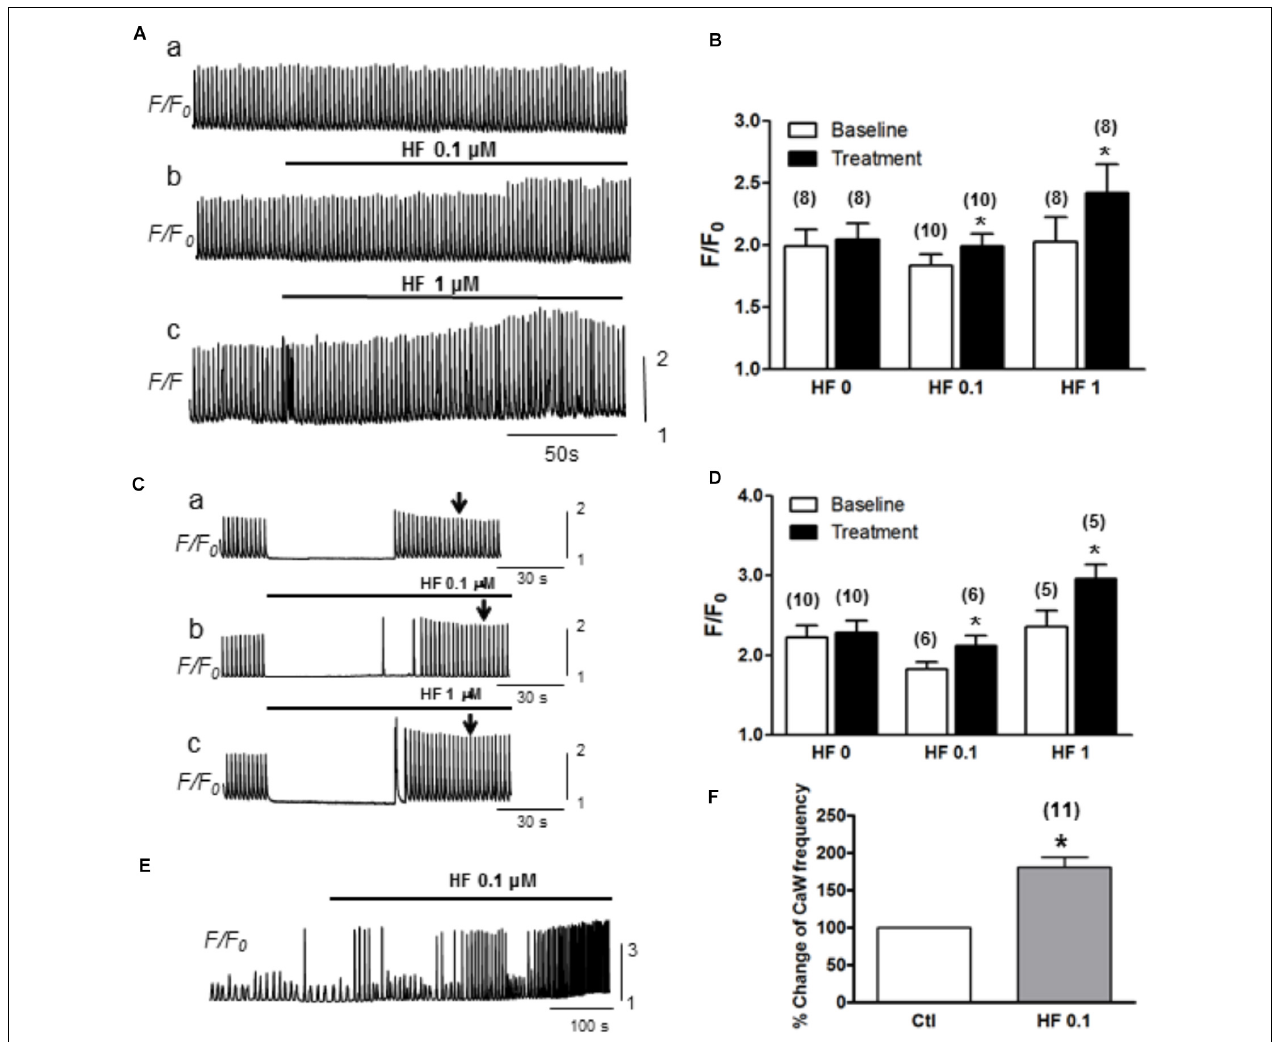
FIGURE 4 | Hyperforin enhances CaT amplitude. (A) A representative trace of CaTs facilitated by hyperforin (0.1 and 1 µ M) when the cell was paced at a pacing cycle length (PCL) of 2 s. (B) Summary of the amplitudes of CaTs potentiated by hyperforin. F/F 0 increased from 1.9 ± 0.1 to 2.1 ± 0.1, n = 10 at 0.1 µ M and from 2.0 ± 0.2 to 2.4 ± 0.1, n = 8 at 1 µ M hyperforin, respectively ( ∗ p < 0.05). (C) Representative traces of calcium transients were measured before and after a 90s-perfusion of hyperforin (0.1 – 1 µ M) while the cells were kept quiescent. (D) Summary of calcium transient amplitude by hyperforin perfusion. (E) A representative trace of Ca 2 + waves (with [Ca 2 + ] 4 mM) facilitated by hyperforin (0.1 µ M). (F) Summary of the changes in Ca 2 + wave frequencies caused by hyperforin, which promotes the Ca 2 + waves by increasing the frequency to 180.5 ± 13.5% ( n = 11, ∗ p < 0.05 vs.